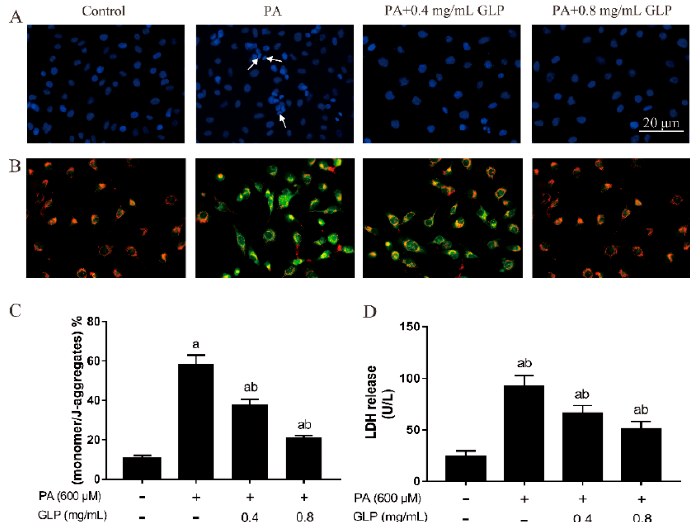
Figure 2. The effects of GLP on apoptotic characteristics in PA-induced IPEC-J2 cells. Cells were exposed to 600 µ M PA with or without 0.4 and 0.8 mg/mL of GLP for 24 h. ( A ) Representative images of 4’,6-diamidi-no-2-phenylindole (DAPI) staining (blue). Arrows denote chromatin condensation and fragmentation. Original magnification 400 × . ( B ) The mitochondrial membrane potential was examined by JC-1 staining. JC-1 aggregate and JC-1 monomer exhibited red and green fluorescence, respectively (400 × ). ( C ) JC-1 staining quantification results are presented as the mean of monomer/J-aggregates ± SE. ( D ) The release of LDH was analyzed using a commercially available kit and calculated as U/L. Data were presented as mean ± SE for three independent experiments ( n = 3), a < 0.01 vs. control, b < 0.01 vs. PA alone.